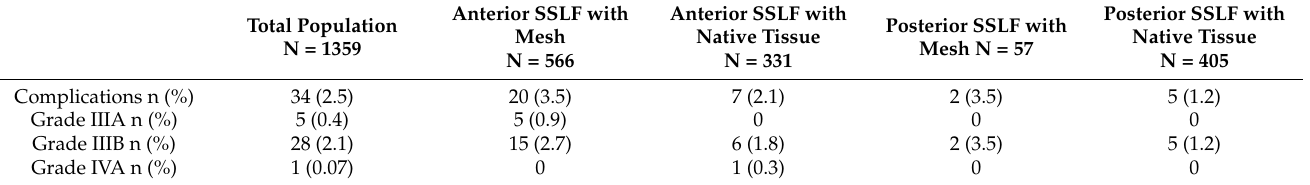
Table 3. Complications between the four surgical groups according to the Clavien–Dindo classification.